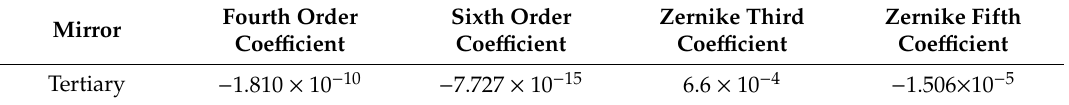
Table 7. Aspheric surface high-order coe ffi cients and Zernike coe ffi cients of the tertiary mirror.